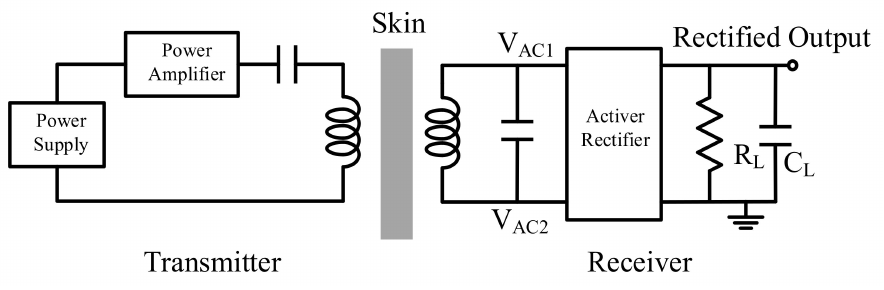
Figure 1. Wireless power transfer